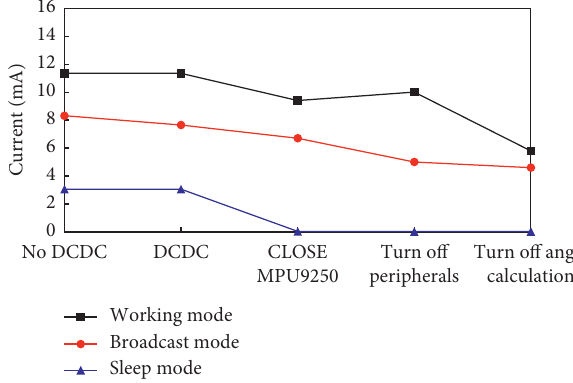
Figure 3: Current consumption under different conditions.